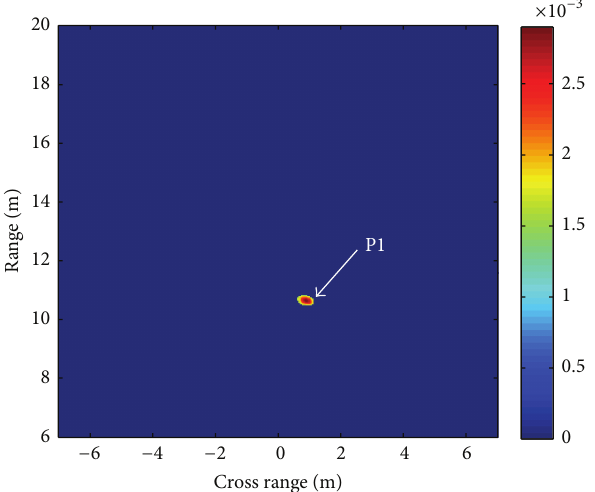
Figure 12: Imaging result after processing by the proposed method in this paper.